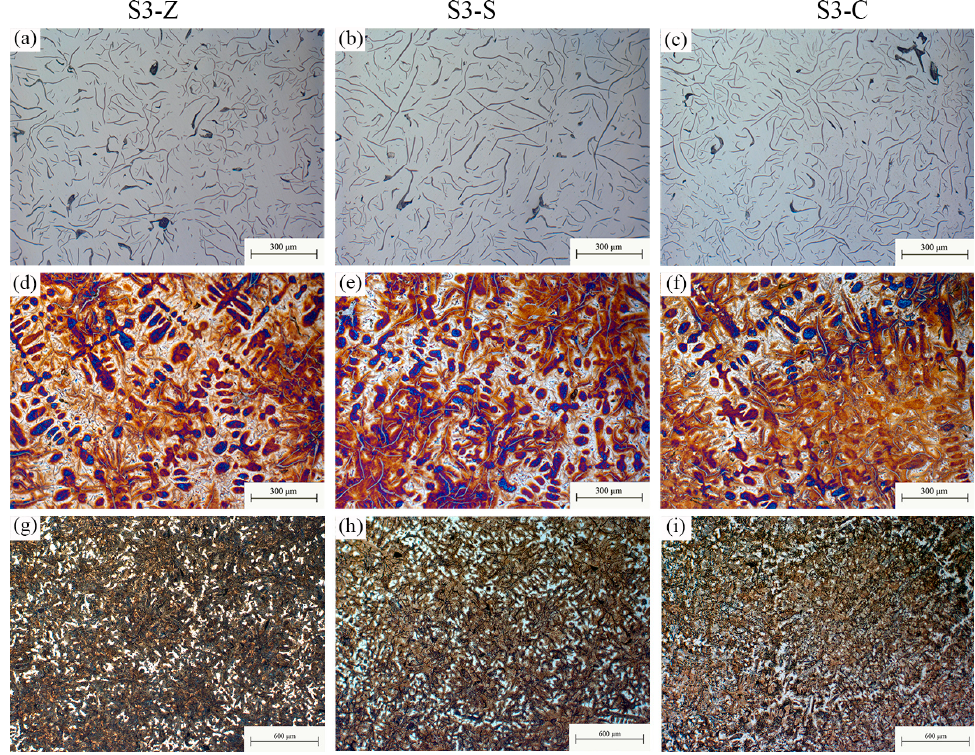
Figure 4. Metallographic images of S3 ‐ Z ( a , d , g ), S3 ‐ S ( b , e , h ) and S3 ‐ C ( c , f , i ), showing graphite ( a – c ), primary dendrite ( d – f ), and eutectic colonies ( g – i ).